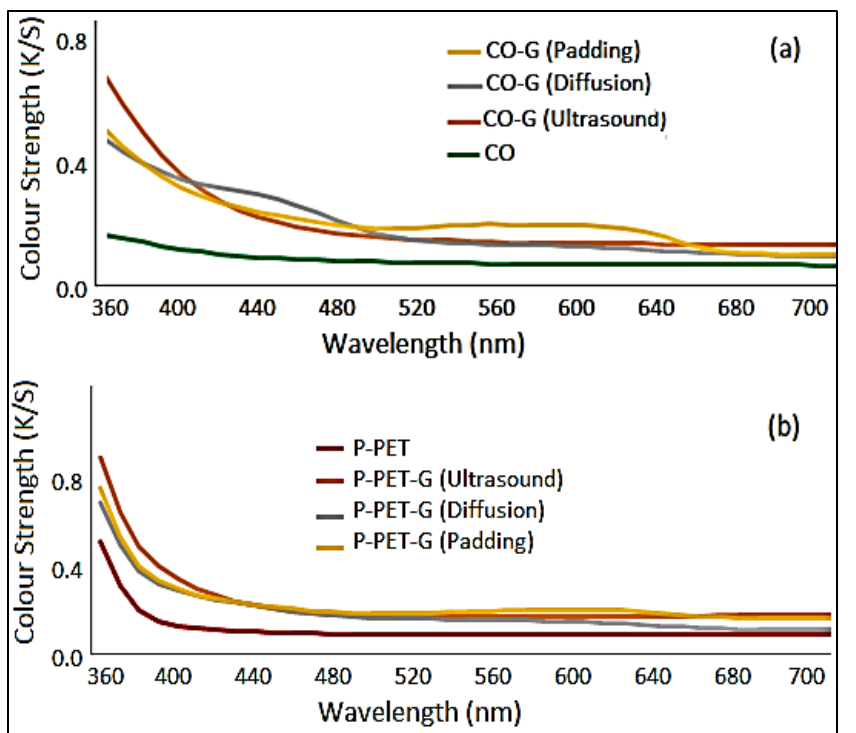
Figure 8. Effect of treatment methods on the color strength of cotton ( a ) and PET ( b ) fabrics treated with geranium essential oil.